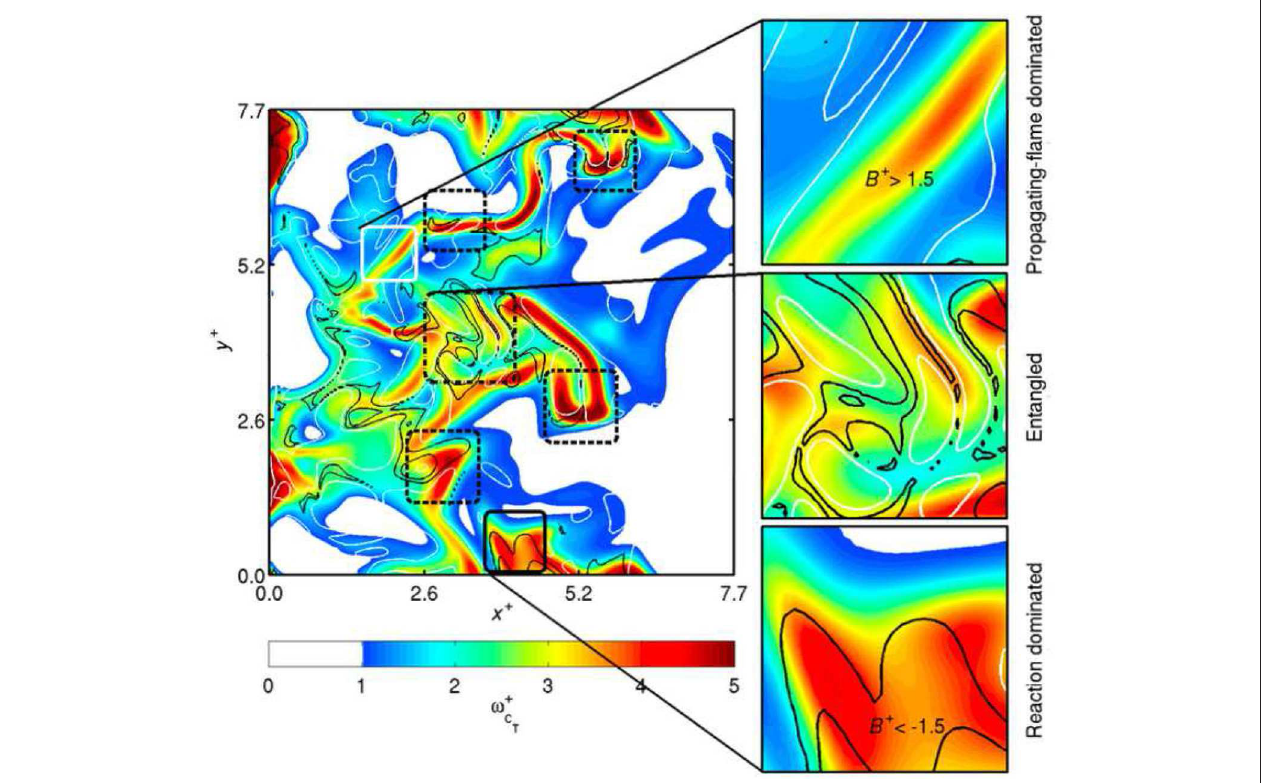
FIGURE 7 | Typical contours of ˙ Q + (color map) are shown along with flame dominated ( B + = 1.5, white contours) and reaction dominated ( B + = − 1.5, black contours) regions from the case P3. The results are shown for the mid x - y plane at an arbitrarily chosen time. Typical reaction and flame dominated regions are marked respectively using a black box and a white box with solid lines, which are enlarged at bottom right and top right respectively. Several regions showing entangled reaction and flame characteristics are marked using black boxes with dashed lines and one of such region is enlarged on the side, adapted from